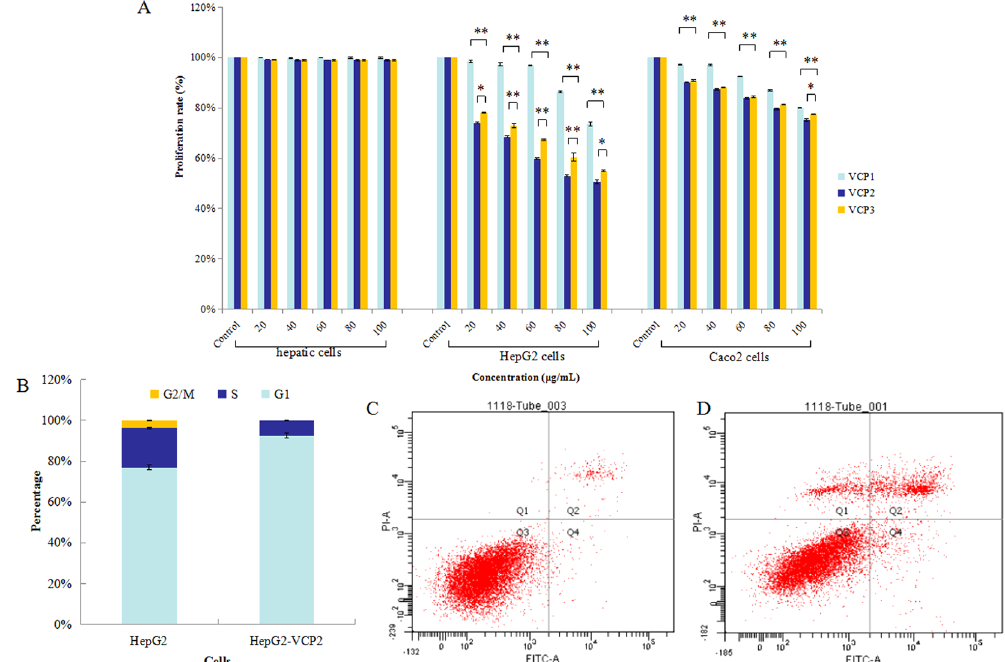
Figure 1. Proliferative inhibited and apoptosis induced by polysaccharides from Viscum coloratum ( Kom .) Nakai treatment in vitro . ( A ) Proliferative inhibited in polysaccharides-treated hepatic cells, HepG2 cells and Caco2 cells at different concentrations. Cell viability was determined by CCK-8 kit assay. ( B ) Effect of polysaccharides on cell cycle distribution in HepG2 cells. Cell cycle distribution was detected by PI staining with flow cytometry. ( C ) Apoptosis in HepG2 cells. Apoptosis was determined by the flow cytometer based on Annexin V-FITC/PI staining. ( D ) Apoptosis induction in polysaccharides-treated HepG2 cells. Values are means ± SD (n = 3), * p < 0.05 and ** p <